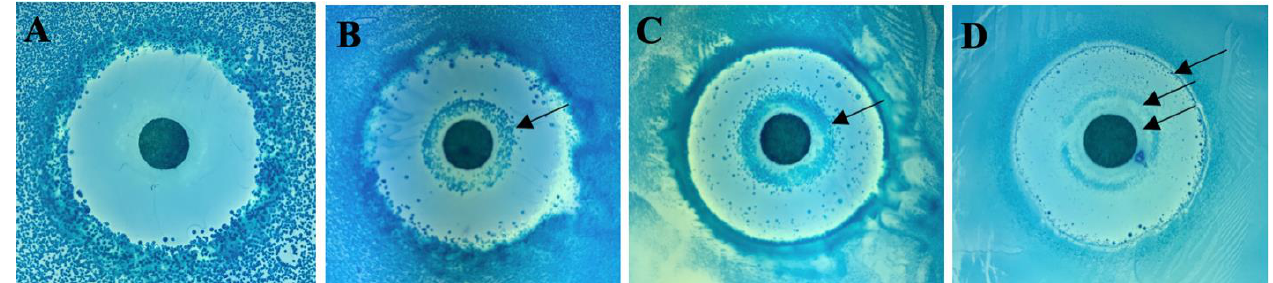
Figure 3. Antibiotic in rhubarb gives multiple zones of inhibition. Serial dilutions (( A ) 10 −4 mL, ( B ) 10 −3 mL, ( C ) 10 −2 mL, ( D ) 10 −1 mL) of an overnight culture of E. coli (MV10) cells were spread on 0.5× LB, 0.5× salt plates for disk diffusion assay. The arrows indicate zones of cell growth within the zone of inhibition.